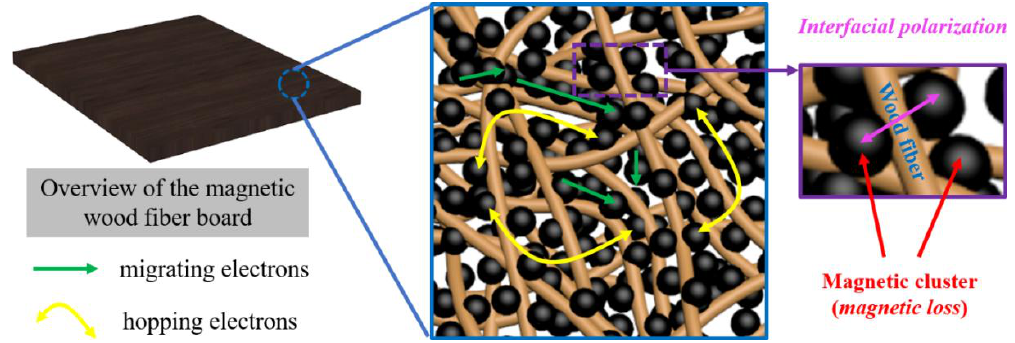
Figure 9. Scheme of primary EMI absorbing processes in the magnetic fiber board (Left): interfacial polarization (Right) at the interfaces between Fe 3 O 4 nanoparticles and the carbohydrates from the wood fiber surface, and conductive network (Middle) constructed by magnetic nanoparticles. The nanoparticles attached on the wood fiber surface and in the spaces among these fibers (as observed in Figure 3C) are labeled as black.